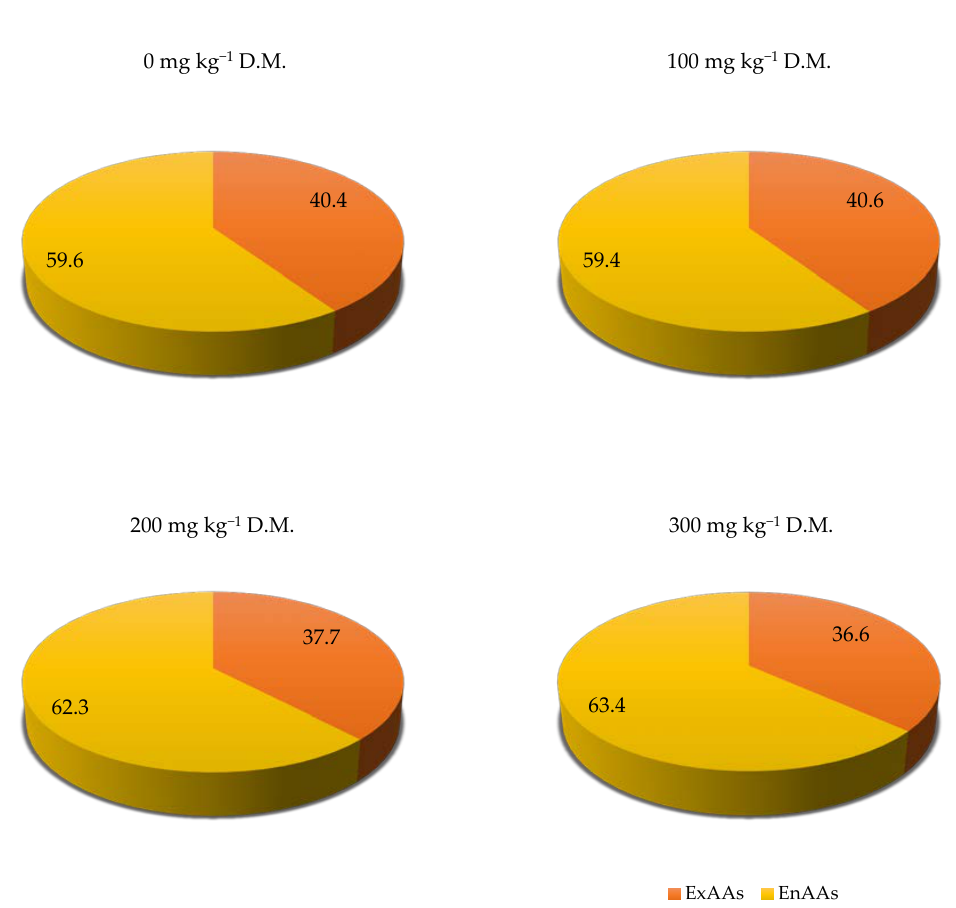
Figure 3. Contribution of ExAAs and EnAAs to TotAAs in the grain of spring triticale ( × Triticosecale Wittm . ex A. Camus) depending on soil contamination with fluorine, in %.